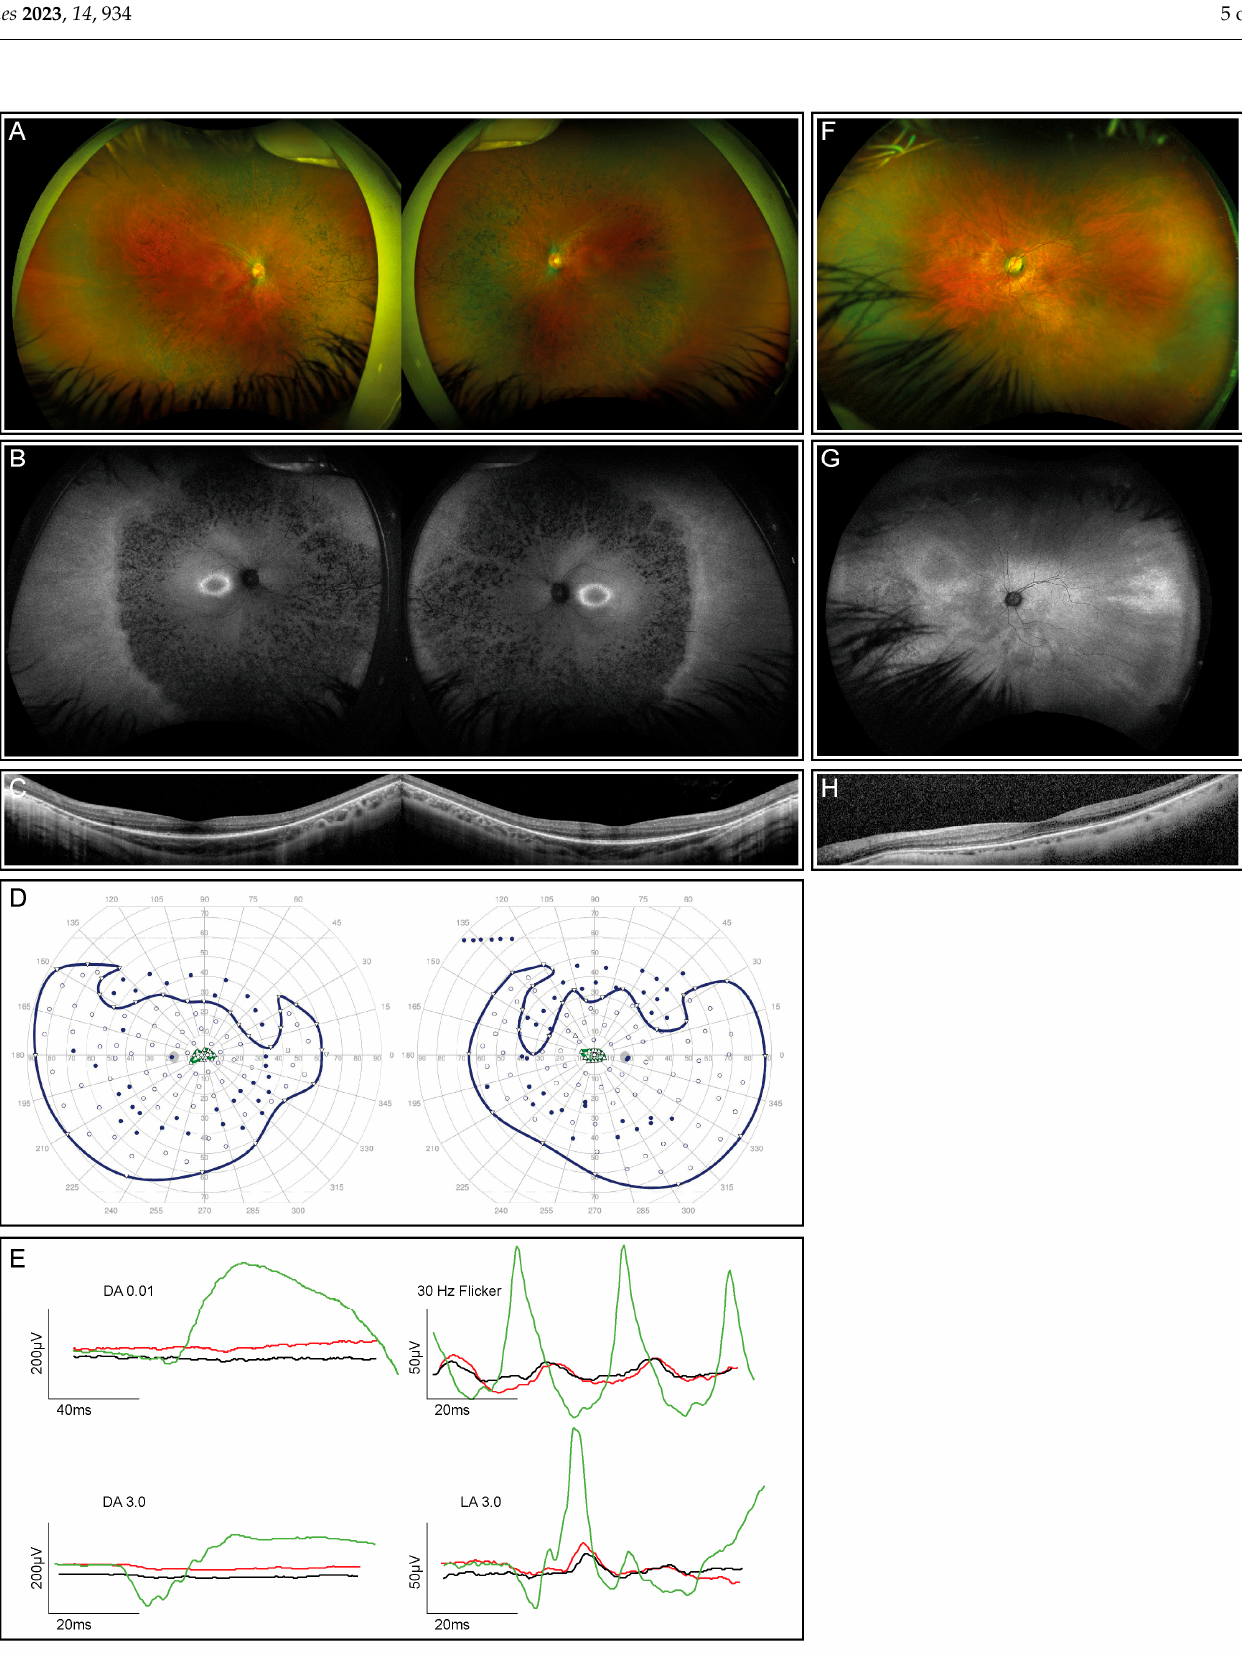
Figure 1. Clinical phenotype for the index patient (both eyes) and his mother (left eye only; right eye not shown due to dense cataract and consequently insufficient image quality). ( A ) Fundus images of the index patient demonstrate advanced retinal dystrophy with bone spicule pigmentation. ( B ) Corresponding autofluorescence images show retinal atrophy and a circular ring of increased